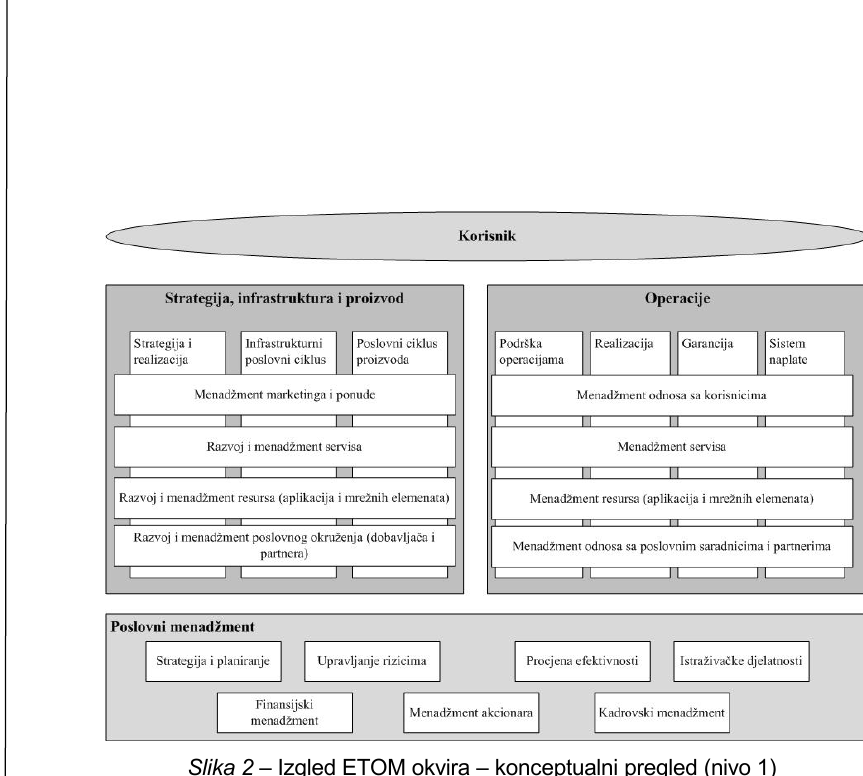
Figure 2 – eTOM business process framework (Level